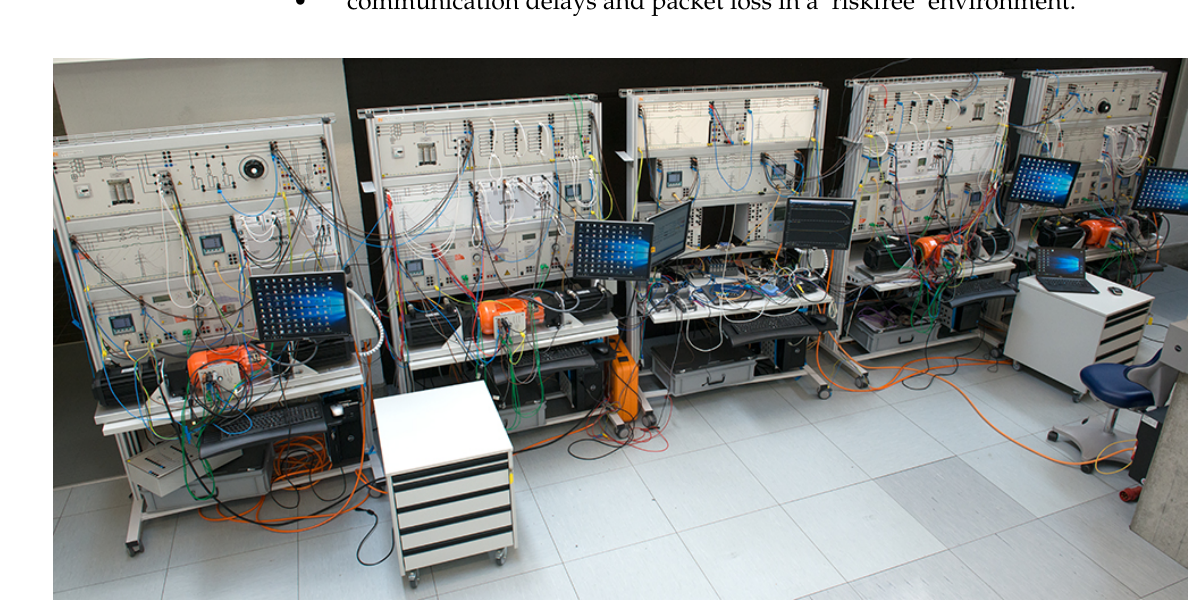
Figure 1. DHEPS in the REE-LAB of ZHAW.